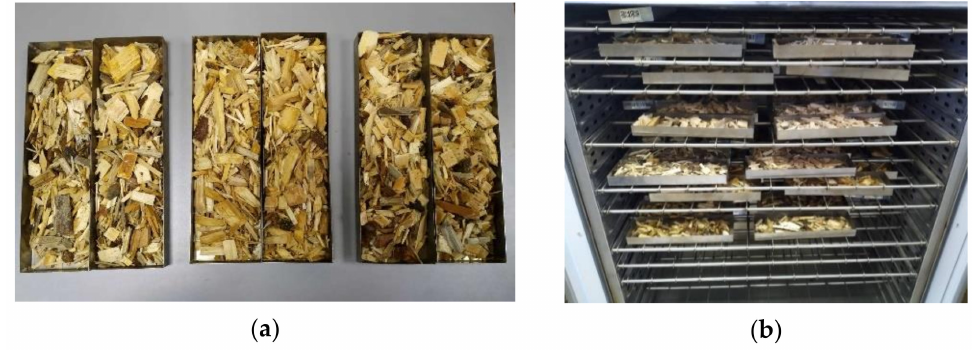
Figure 1. Examples of samples: ( a ) two sub-sample sets and ( b ) samples drying in the oven.